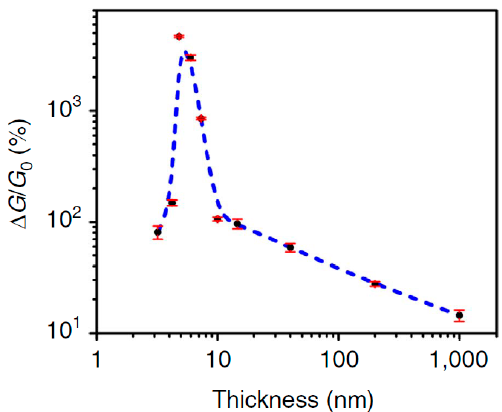
Figure 10. The influence of phosphorene nanosheets thickness on the conductivity response to NO 2 (500 ppb) in dry air. Reproduced from Ref. [90]. Published by Macmillan Publishers Limited as open access, 2015.